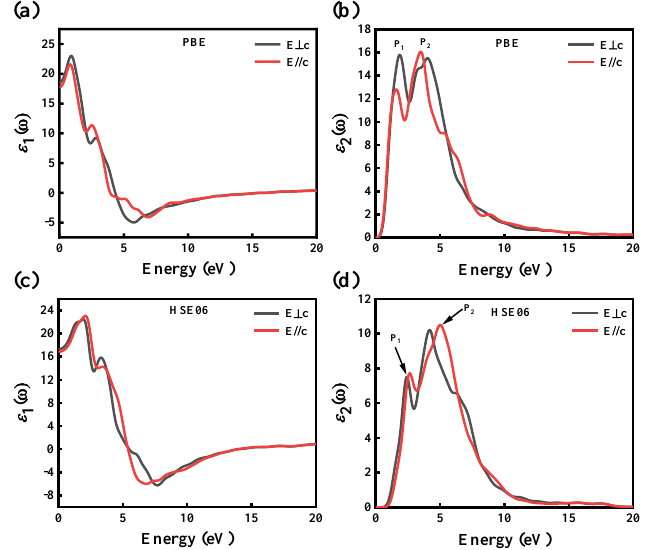
Figure 5. ( a ) The real part and ( b ) the imaginary part of the dielectric function of CdGeAs 2 of GGA–PBE; ( c ) the real part and ( d ) the imaginary part of the dielectric function of CdGeAs 2 of HSE06.